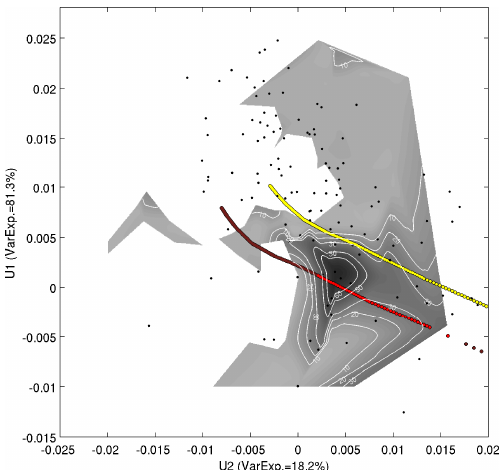
Figure 11. The relative concentration of Phaeocystis (gray tones) in the orthogonal U 1 –U 2 plane, calculated from the SVD of an R matrix composed of 141 registers from the MAREDAT database in the period between 2002 and 2009. The orthomodels for Phaeocystis and Diatoms are shown as red and yellow dots, respectively. The bright red dots show the proposed adjustment for the Phaeocystis orthomodel.